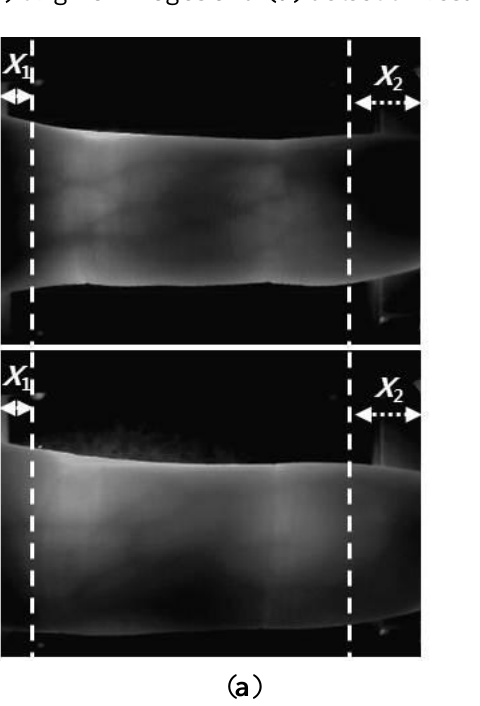
Figure 4. Examples of finger region detection using images from database II: ( a ) original images and ( b ) detection results for the finger